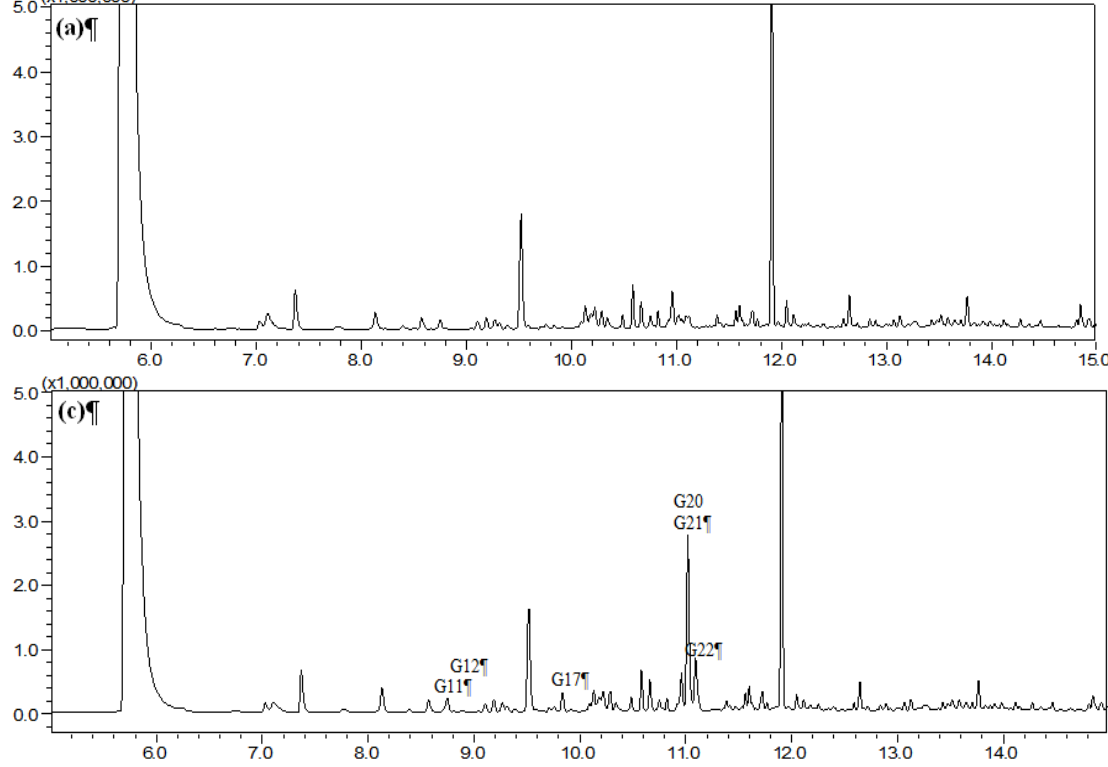
Figure 4. Total ion chromatograms of cerebrospinal fluid (CSF) obtained from ( a ) blank group and ( c ) Asari Radix et Rhizoma (AR) powder group using